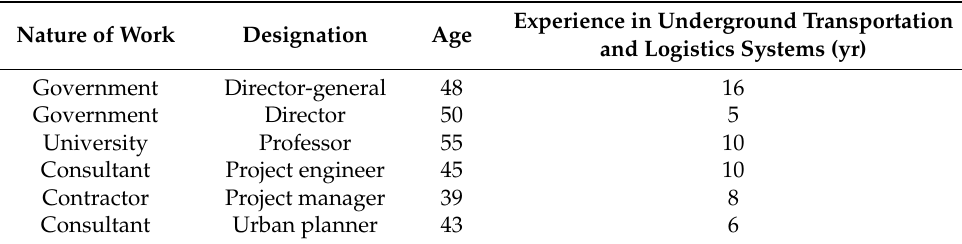
Figure 1. The methodology roadmap adopted in the study. Table 1. Profile of consulted